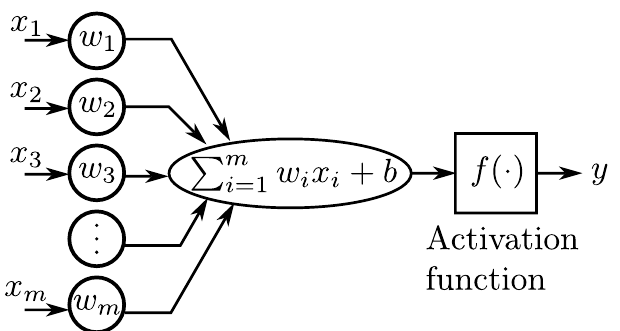
Figure 2. Diagram of a simple